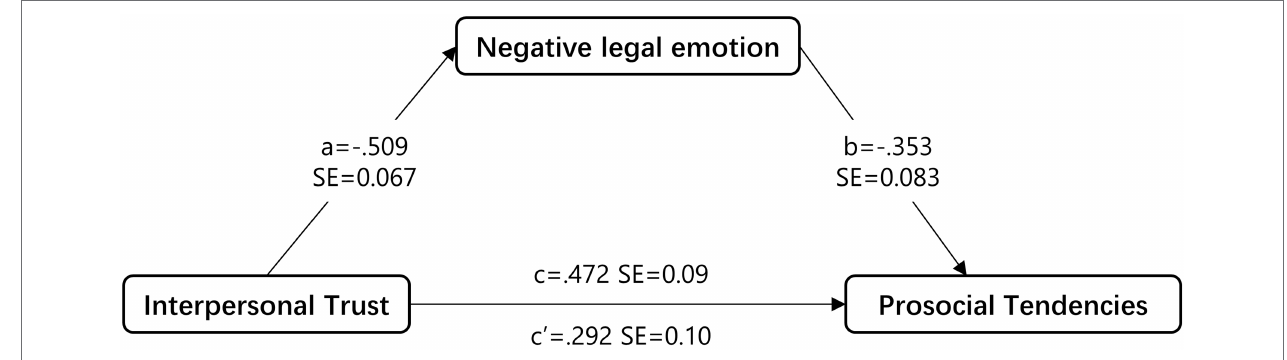
FIGURE 2 | Hypothesized model with negative legal emotion as the mediator between interpersonal trust and prosocial tendencies for the entire sample. Unstandardized regression weights are presented. Controlled variables (age and gender) are omitted for clarity. All paths were significant at the p < 0.01